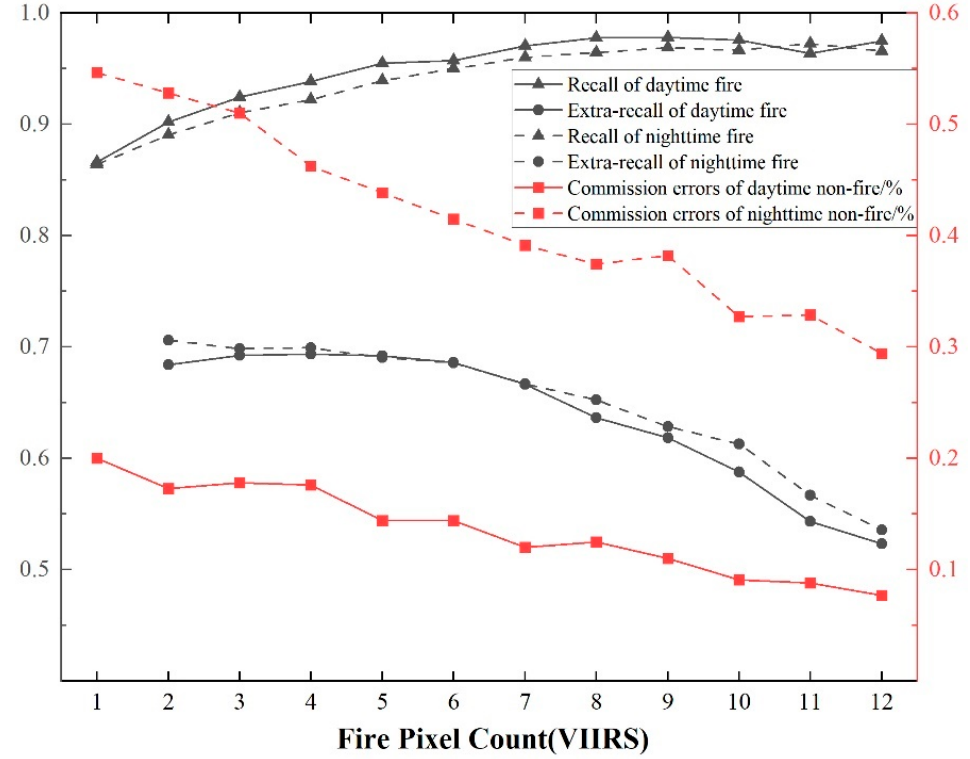
Figure 5. Accuracy of RF models on the validation dataset with fire label datasets constructed with different fire pixel counts as thresholds.